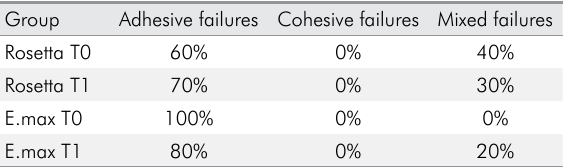
Table 4. Failure mode percentage (%) following microshear bond strength test for CAD-CAM lithium disilicate glass ceramic systems immediately (T0) and after 30 days (T1).